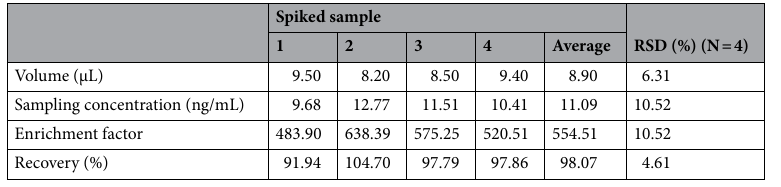
Table 1. Recovery assay, Recovery assay, precision (repeatability) and trueness of target compounds in greentea.